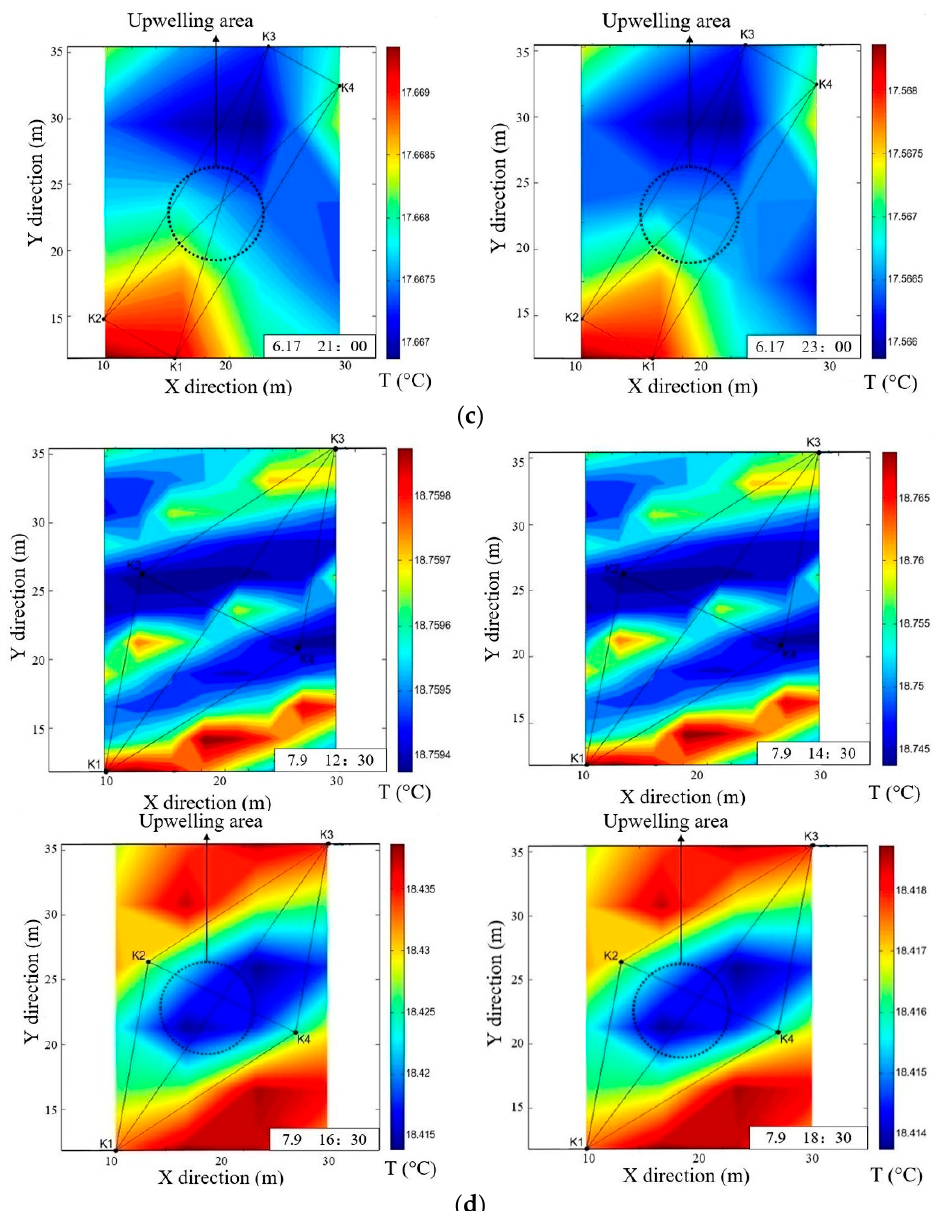
Figure 8. Horizontal mapping. ( a ) Temperature field mapping for right triangle layout; ( b ) Temperature field mapping for isosceles triangle layout; ( c ) Temperature field mapping for rectangular layout; ( d ) Temperature field mapping for lozenge layout.